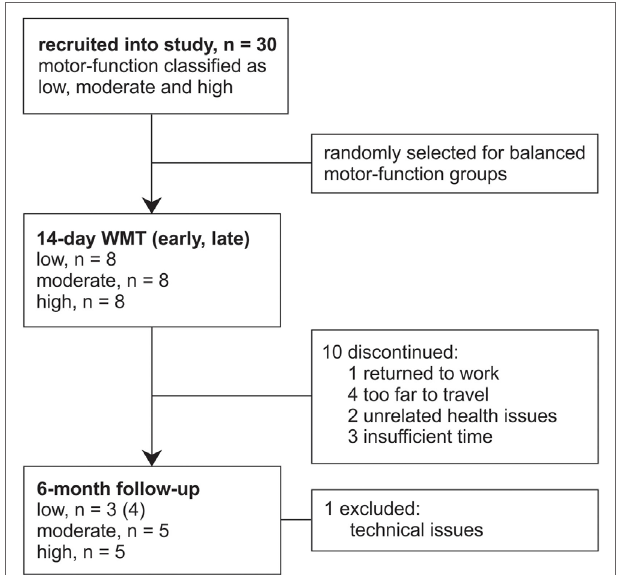
Figure 1 | Flow of patients through this study. Patients were recruited from concurrent studies of Wii-based Movement Therapy (WMT) for this data